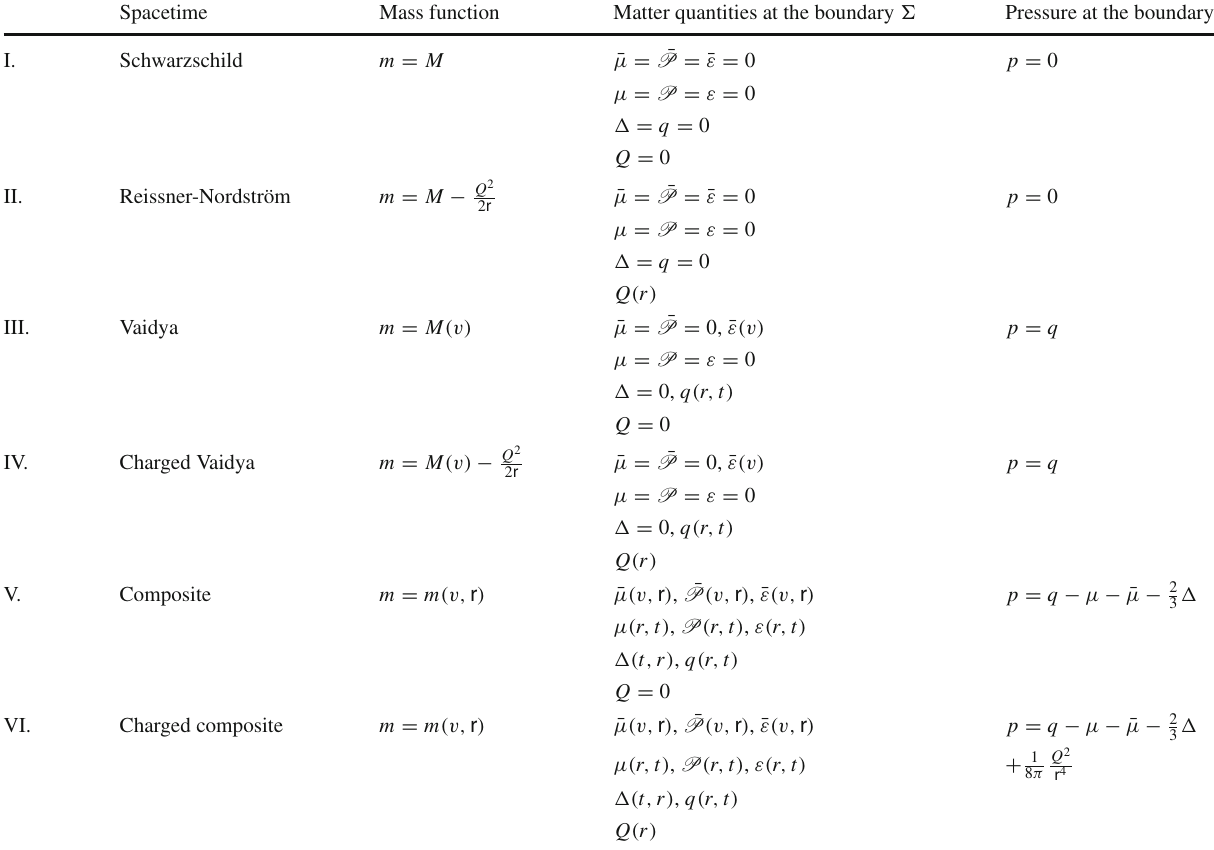
Table 1 Spacetimes, mass functions and boundary